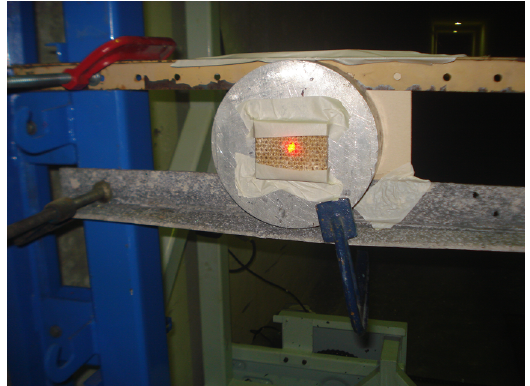
Figure 2. Sisal fiber composite sample mounted for the residual velocity test. Where m is the mass of the bullet; v the bullet immediately before impacting the target; v residual velocity immediately after impacting the